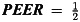
Gadolinium reconstruction errors versus its distance to the center in the case of PEER = 12.(a) The results in the case of the Gadolinium spot, and (b) is the results in the case of a Gadolinium strip.